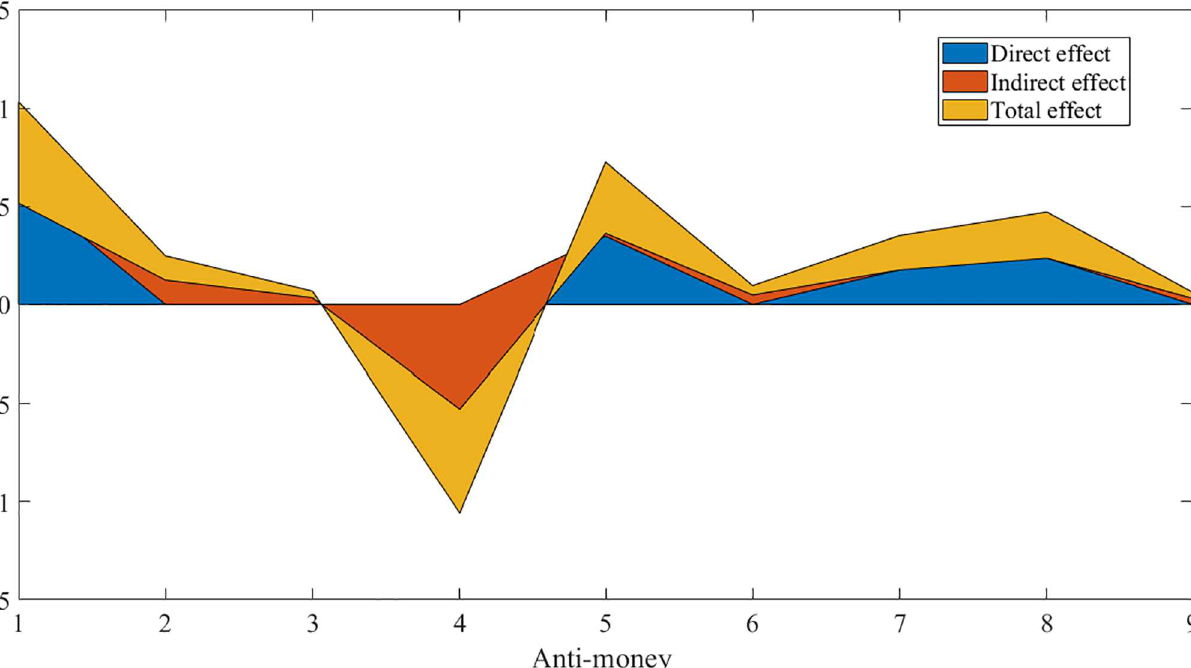
PLOS ONE | https://doi.org/10.1371/journal.pone.0258627 December9,